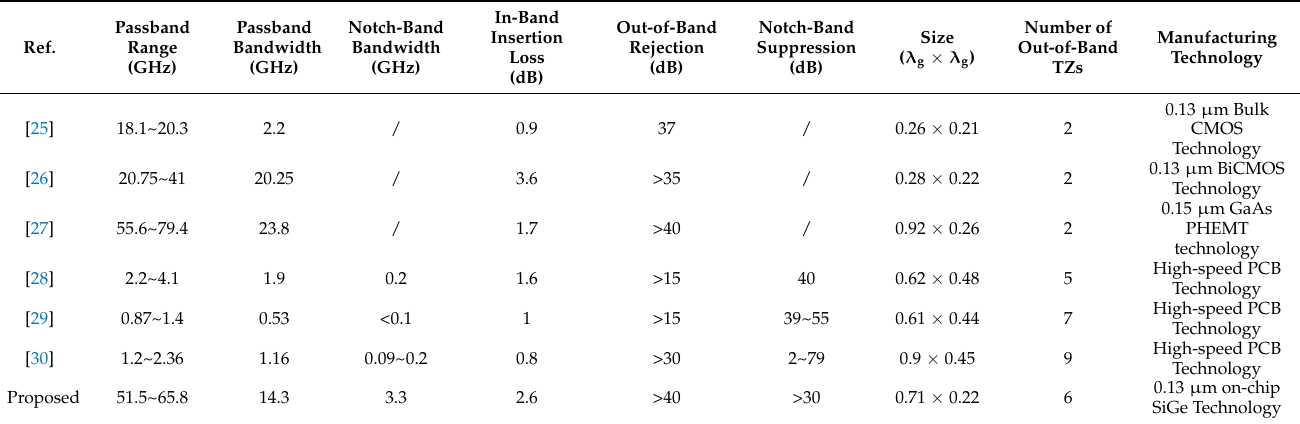
Table 1. Comparison of some recently published